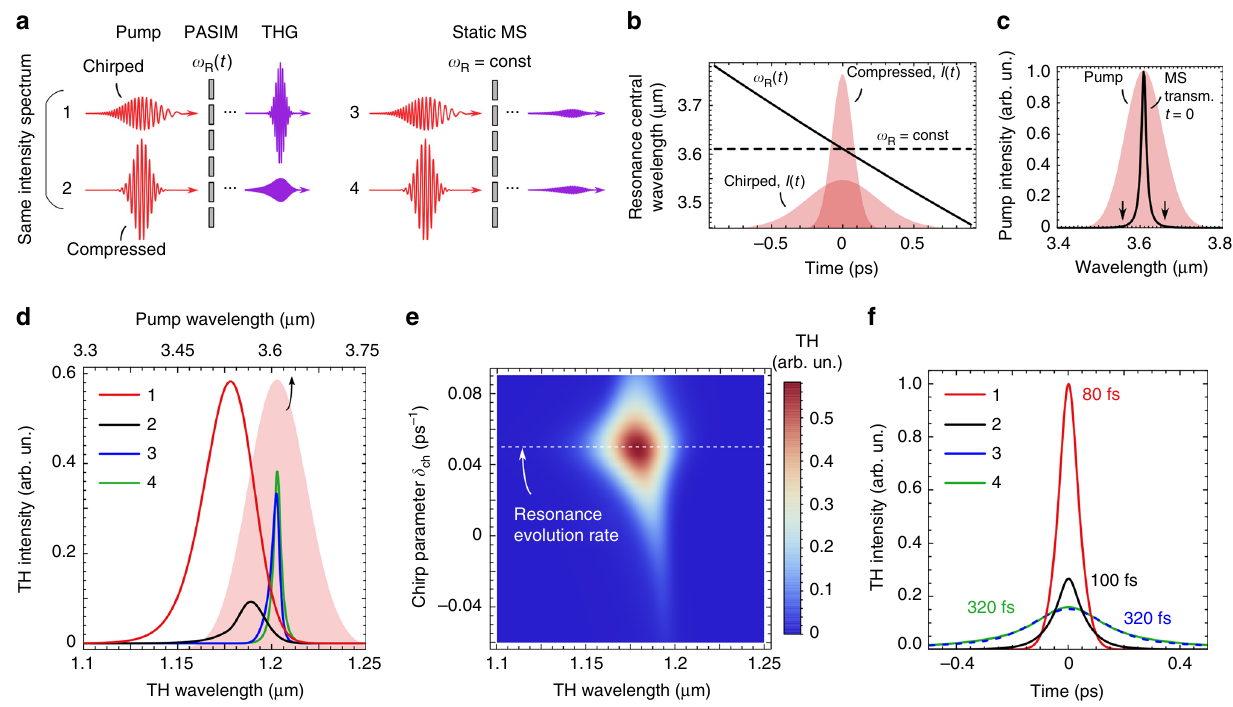
Fig. 4 Nonlinear interaction of broadband pulses with narrow-band metasurfaces. a Third harmonic generation (THG) from a narrow-band photon accelerating semiconductor infrared metasurface (PASIM) (cases 1 and 2) and static metasurface (MS) (cases 3 and 4) using broadband pulses, chirped or transform-limited (compressed). b Evolution of the MS resonance frequency ω R ( t ) for a PASIM (solid line) and a static MS (dashed line) superimposed with the temporal pro fi les (shaded areas) of the chirped ( τ L = 500 fs) and compressed ( τ L = 150 fs) mid-infrared (MIR) pulses with the same energy and spectral width. c Intensity spectrum of the pump (shaded area) and transmittance spectrum of the metasurfaces at t = 0 (black curve): Δ ω L ≈ 8 Δ ω R . The arrows indicate the sweep range of the PASIM ’ s ω R ( t ) within the temporal full width at half-maximum of the chirped MIR pulse. d Spectra of THG generated in cases 1 – 4. Shaded area referenced to the top axis: the spectrum of the MIR pulses. e THG emission from the PASIM for different values of the chirp parameter δ ch . Both the bandwidth and ef fi ciency peak at δ ch = α . f THG pulses generated in cases 1 – 4 after perfect compression, illustrating the possibility of generating ultrashort ( τ TH < 80 fs) bursts of the THG radiation by the PASIM. Metasurfaces ’ parameters: α = 0.05 ps − 1 (for PASIM), Δ ω R = 1 ps − 1 (for both